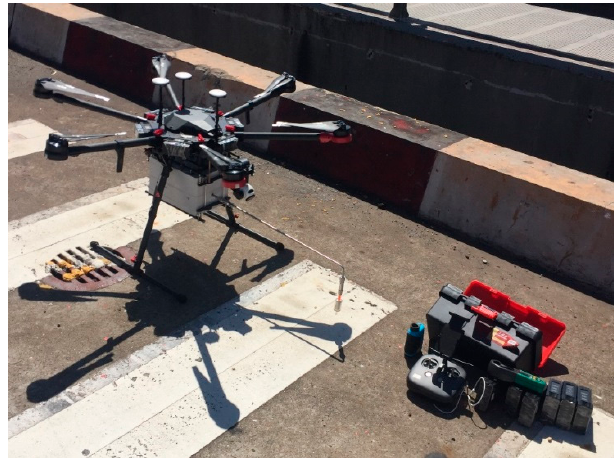
Figure 1. Schematic showing the system architecture of the unmanned aerial system (UAS). UAV, unmanned aerial vehicle; GPRS, general packet radio service; DTU, data transfer unit.